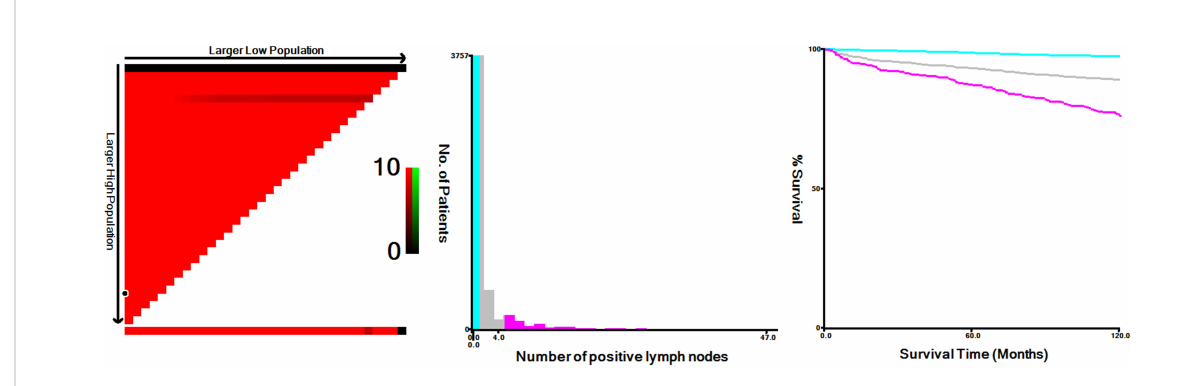
FIGURE 2 X-tile analysis of 10-year disease-speci fi c survival using patients ’ data in SEER registry. The optimal cut-off values for the positive node number were 0, 1 and 4 in the training cohort ( c 2 =333.0712, P <